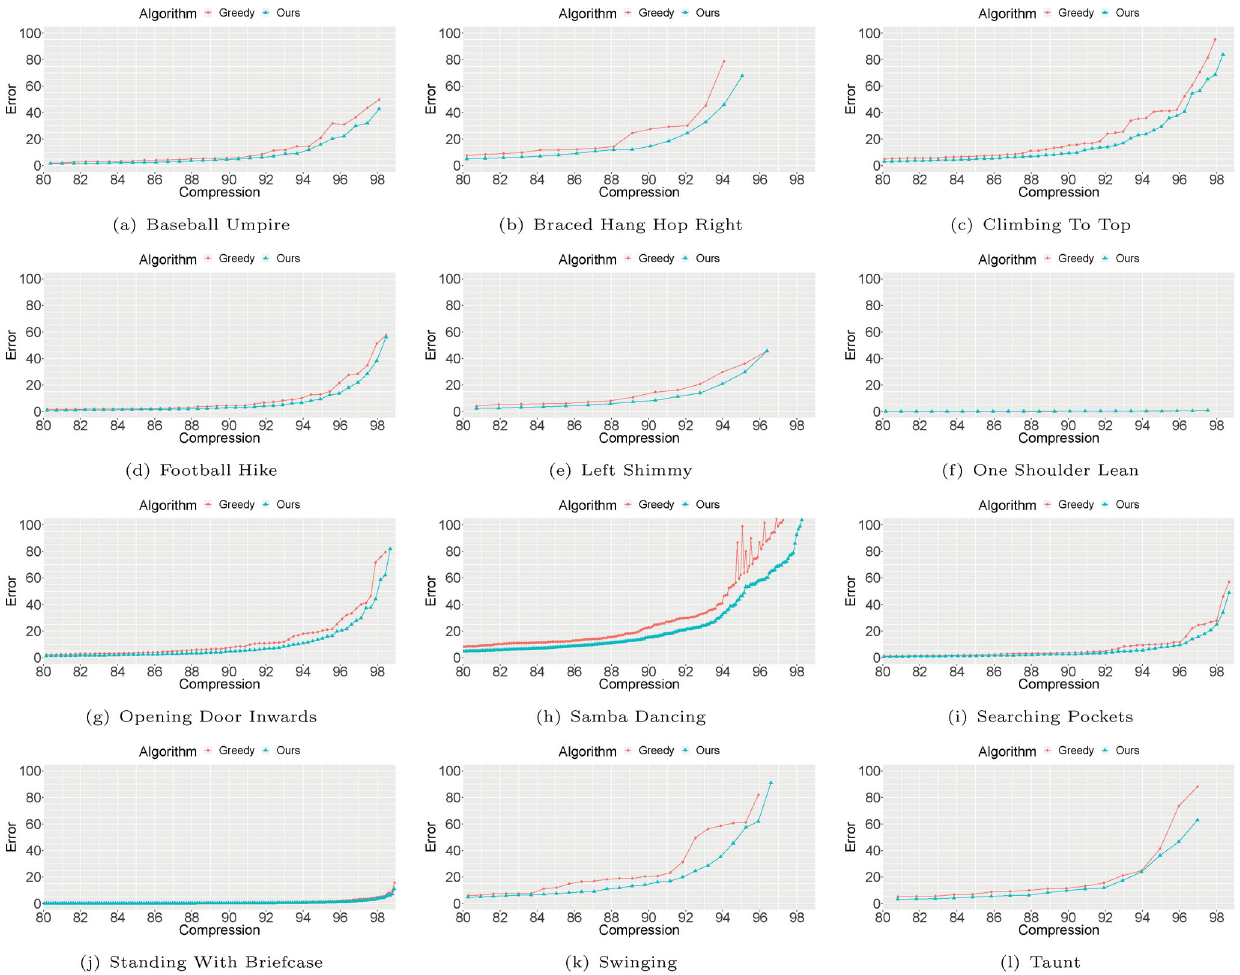
Fig. 10 A comparison between Salient Poses and the greedy approximation algorithm [20]. The horizontal axes present compression. In this case, compression is measured as the percentage of keyframe reduction: the ratio between the number of selected keyframes and the number of keyframes in the original mocap sequence. The vertical axes depict approximation error. In this case, error is quantified as the maximum distance between a piecewise linear interpolation of the selected keyframes and each frame of the original animation. See Section 3.3 for further